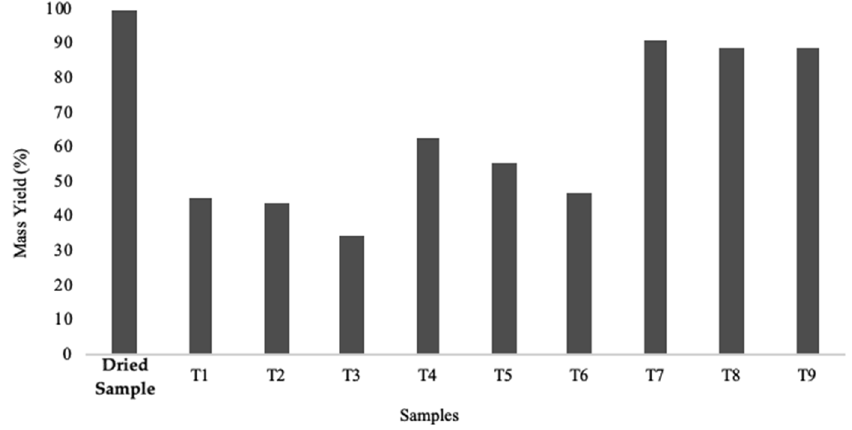
Figure 11. Graphic representation of the mass yield obtained for dry and all torrefied samples. Dry biomass was used as the control sample.